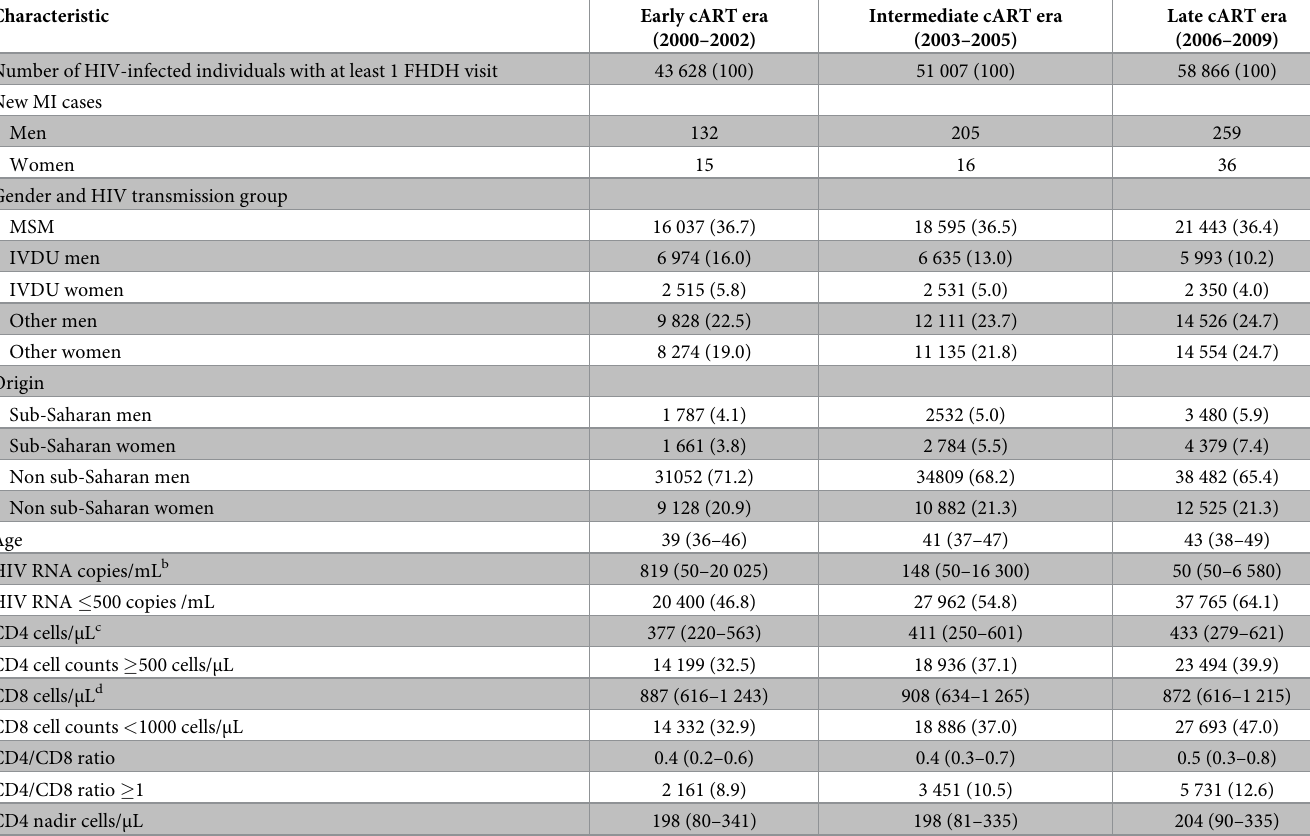
Table 1. Individual characteristics at entry in each calendar period a